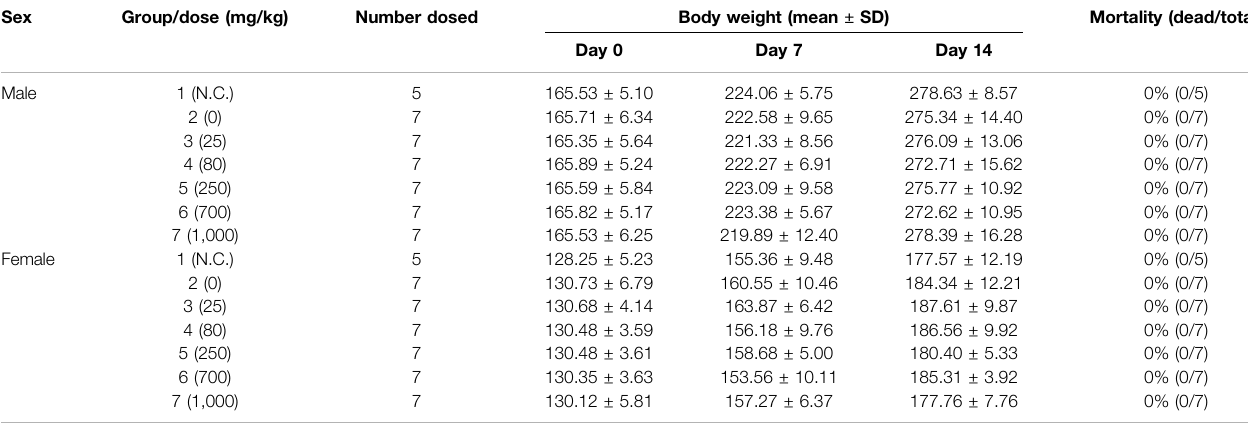
TABLE 1 | The mortality of rats during the single-dose toxicity study. Sex